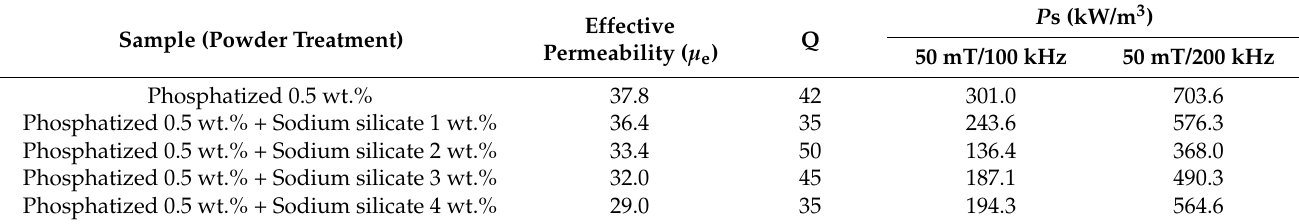
Table 1. Effective permeability μ e , Q and core loss P s of the SMCs with 0.5 wt.% H 3 PO 4 -ethanol solution and different concentration of sodium silicate-aqueous solution.